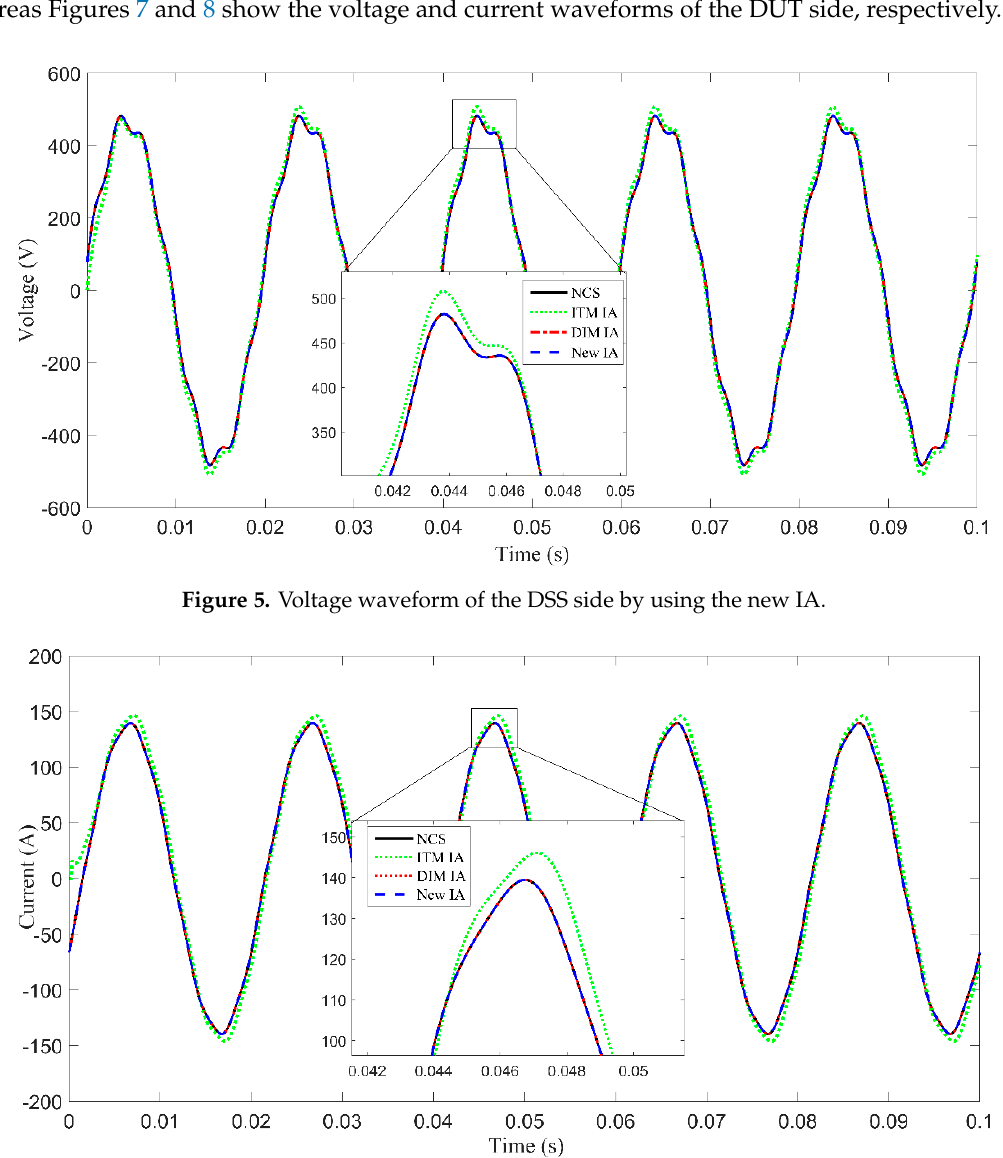
Figure 6. Current waveform of the DSS side by using the new IA.